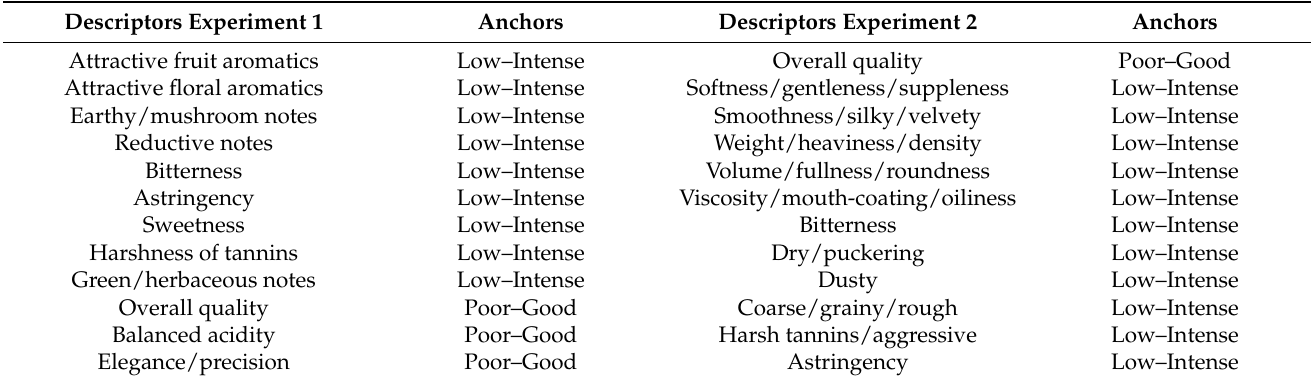
Table 2. Wine attributes rated in Experiments 1 and 2. The attributes were rated as descriptors on 10-point category scales ranging from 1 to 10 in each sensory procedure. The anchors for each 10-point scale are